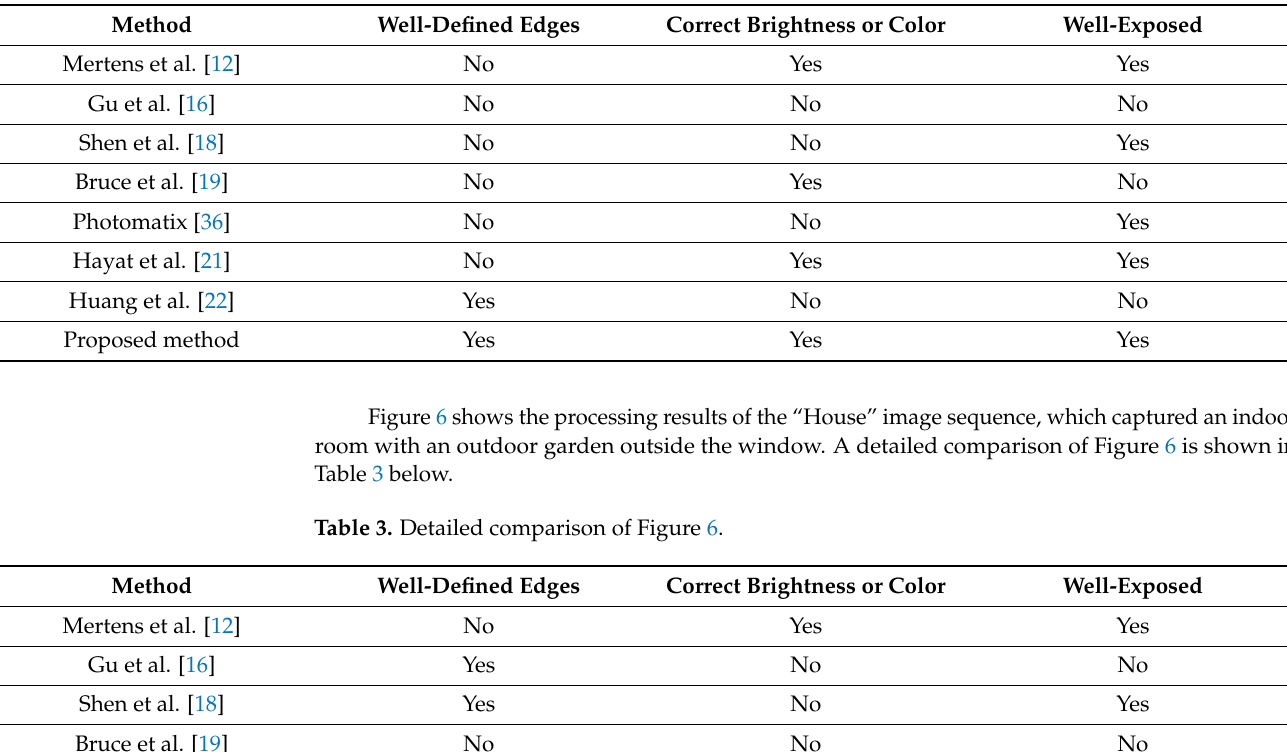
Table 2. Detailed comparison of Figure 5.